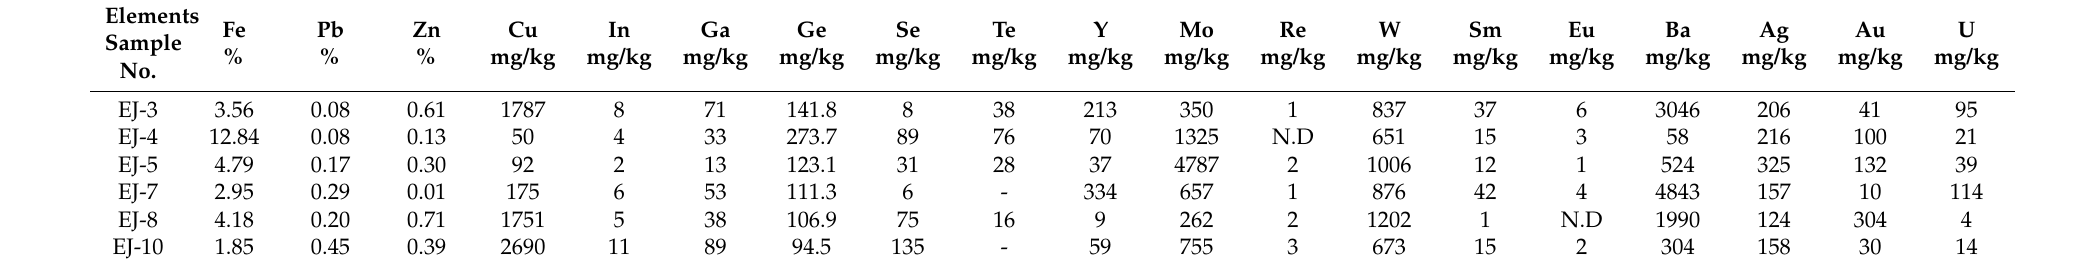
Abbreviations: N.D. = not